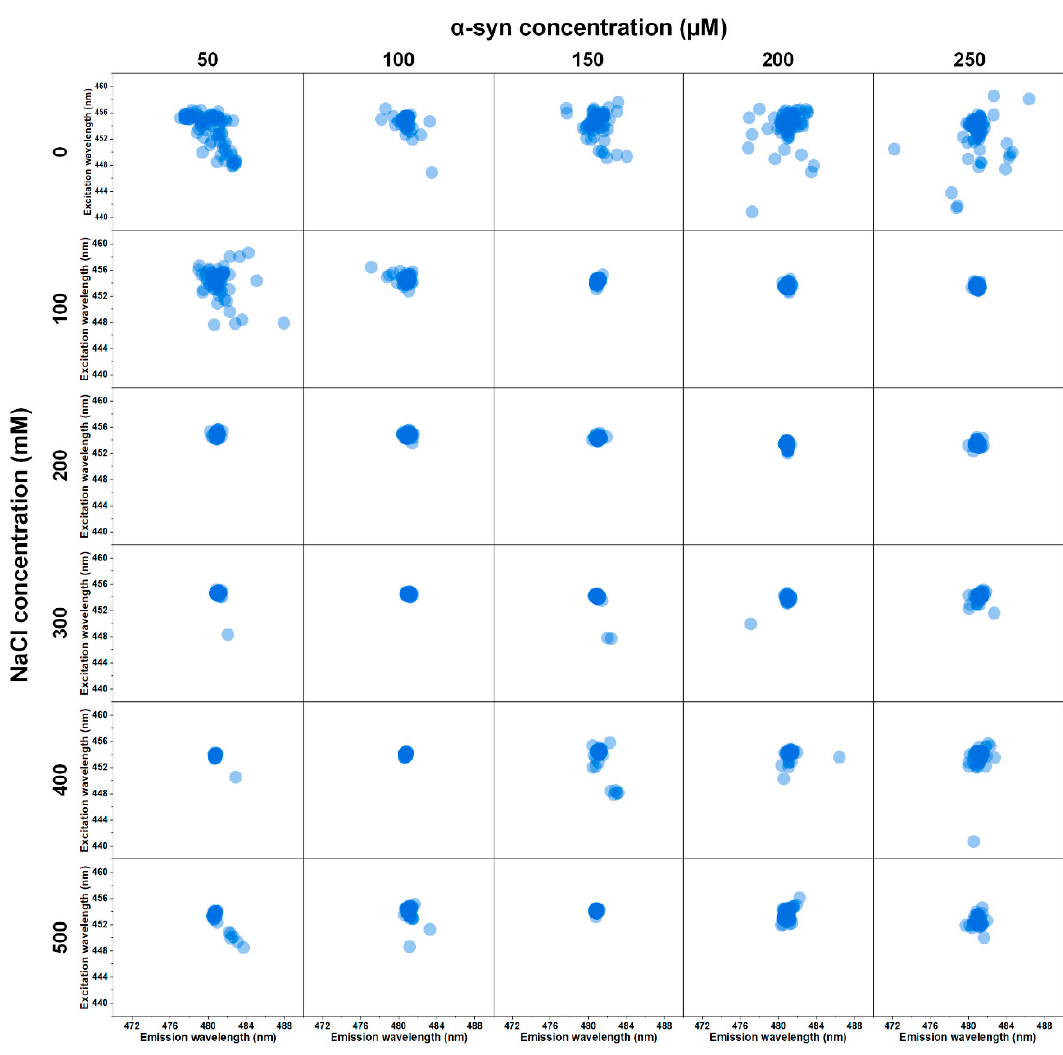
Figure 2. Excitation-emission matrix (EEM) maximum intensity positions of α -syn fibril-bound-ThT, determined for sample sets under thirty different environmental condition. Each position was calculated as described in the Materials and Methods section, at 25 °C, under identical ionic strength (500 mM NaCl) and protein concentration (10 µM) in order to have identical ThT binding conditions. EEM raw data are available as Supplementary Material.